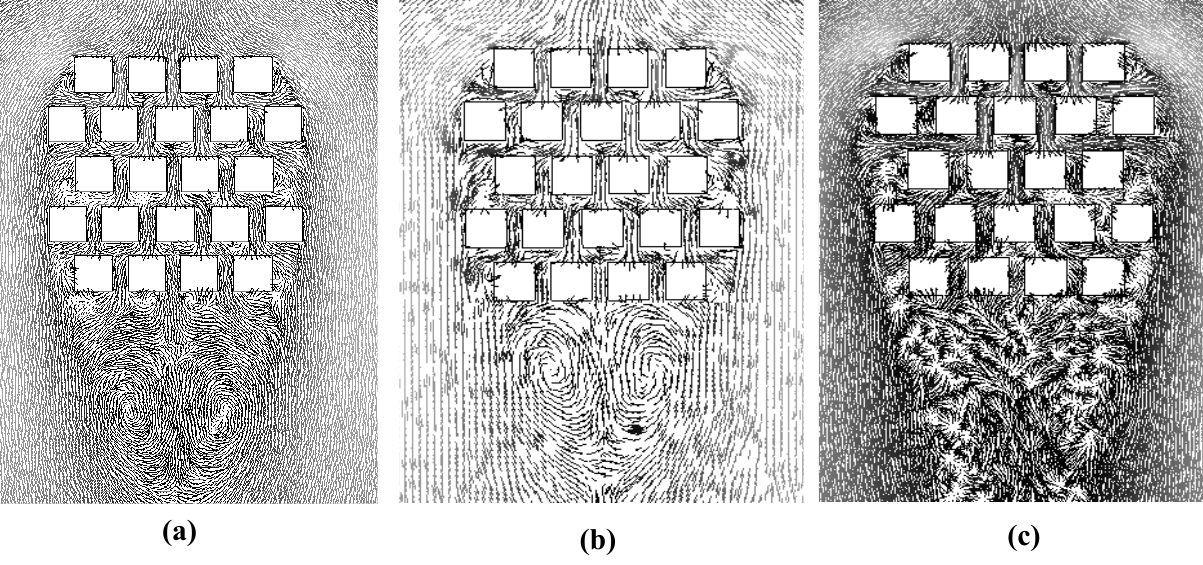
Fig. 9. Comparison between the velocity vectors simulated. (a) Standard k- ε ; (b) RNG; (c) realizable k- ε